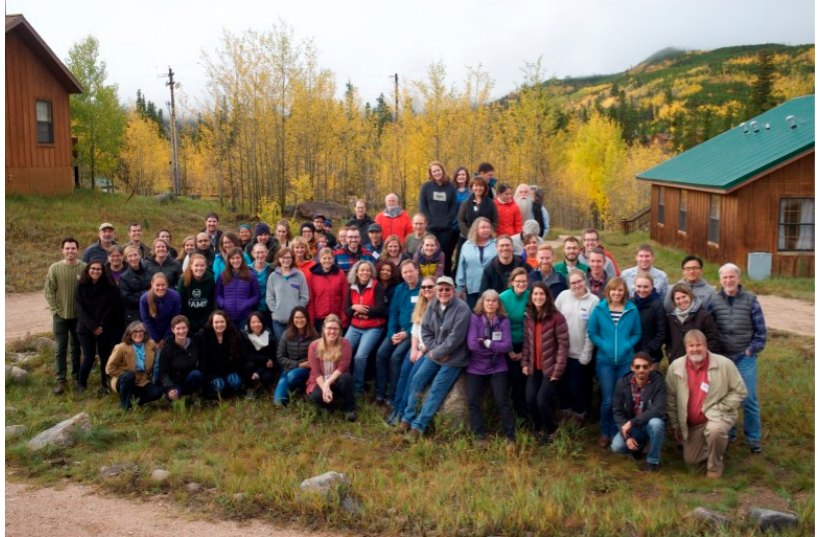
Figure 2. Attendees at the 2017 meeting of the Rocky Mountain Virology Association in the Mountain Campus of Colorado State University.